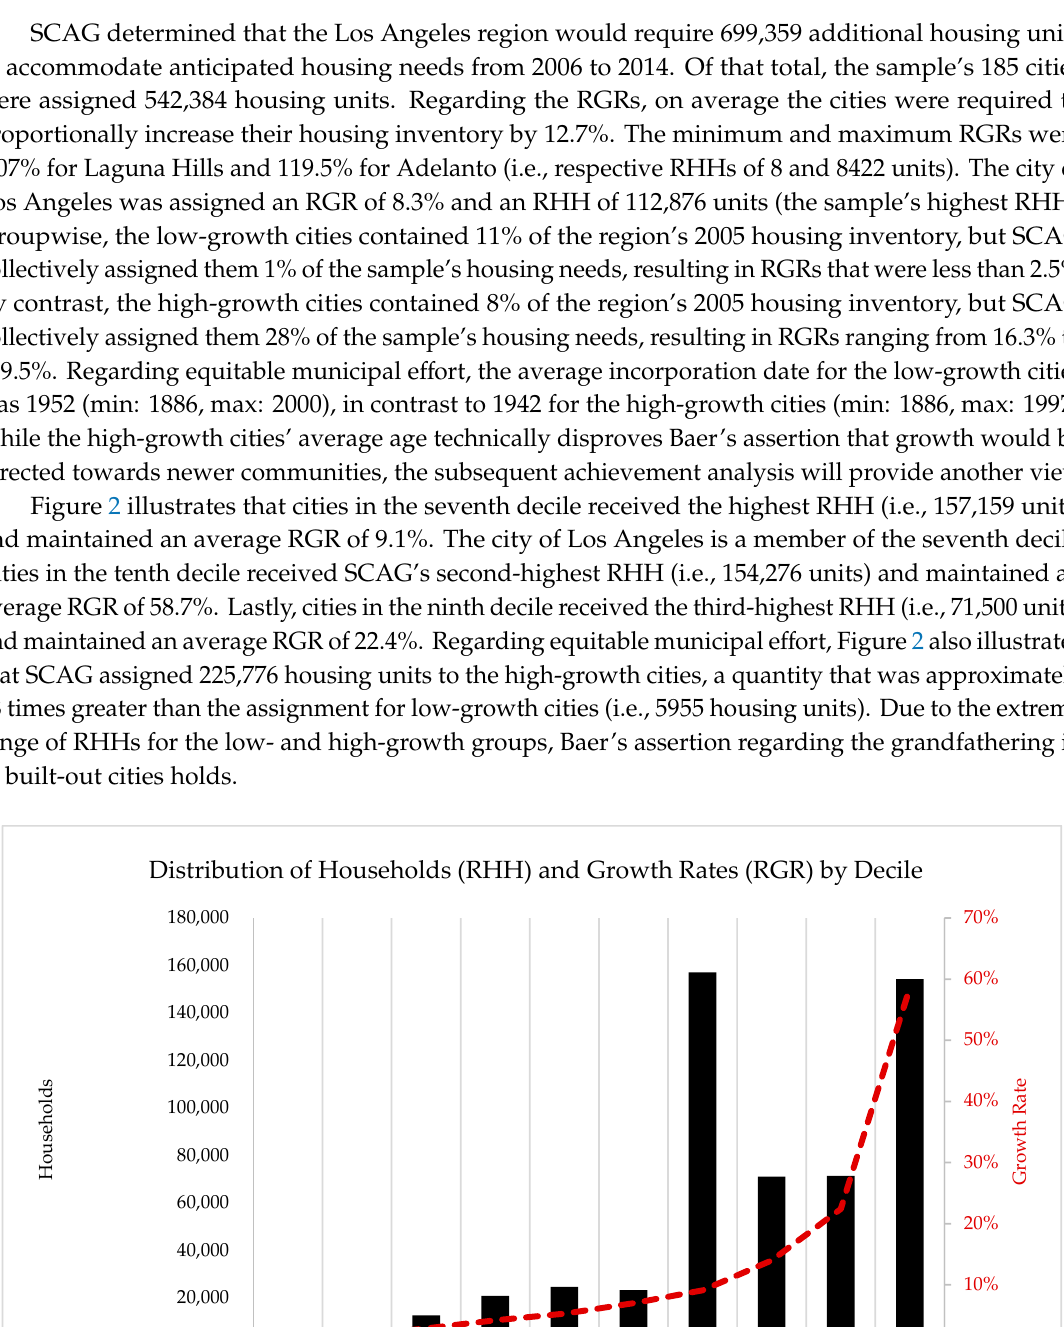
Figure 3. Map of the Los Angeles Region Cities by RHNA Growth Rates (RGR). The sample’s 185 cities were ranked from lowest to highest RGRs and then divided into deciles. This map illustrates that SCAG proportionally assigned high RGRs to the region’s outlying cities (e.g., Apple Valley, Barstow, Brawley, Imperial City, Lancaster, and Twentynine Palms). By contrast, SCAG proportionally assigned low RGRs to coastal cities like Malibu, Rancho Palos Verdes, and San Clemente. Note that the extrusion heights are not to scale. Source. SCAG.